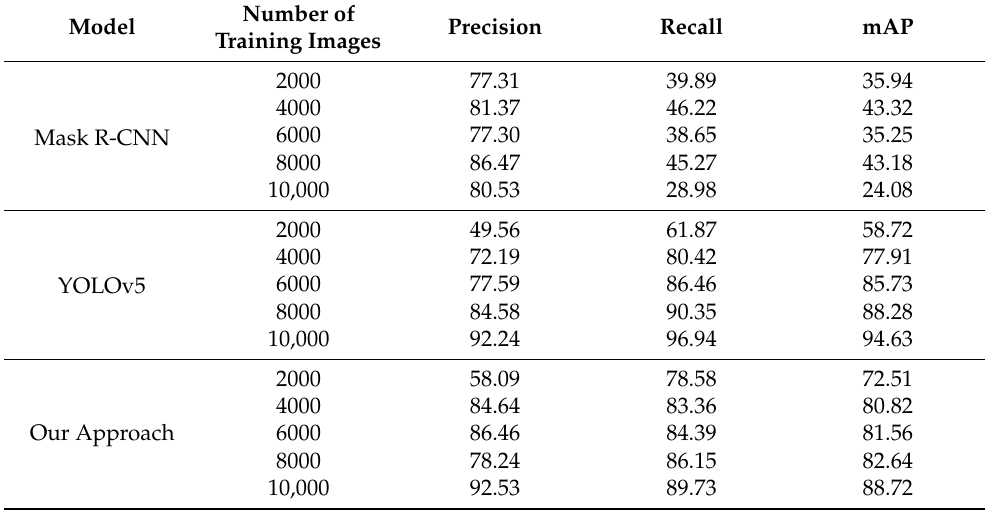
Table 9. Results of different numbers of training images.